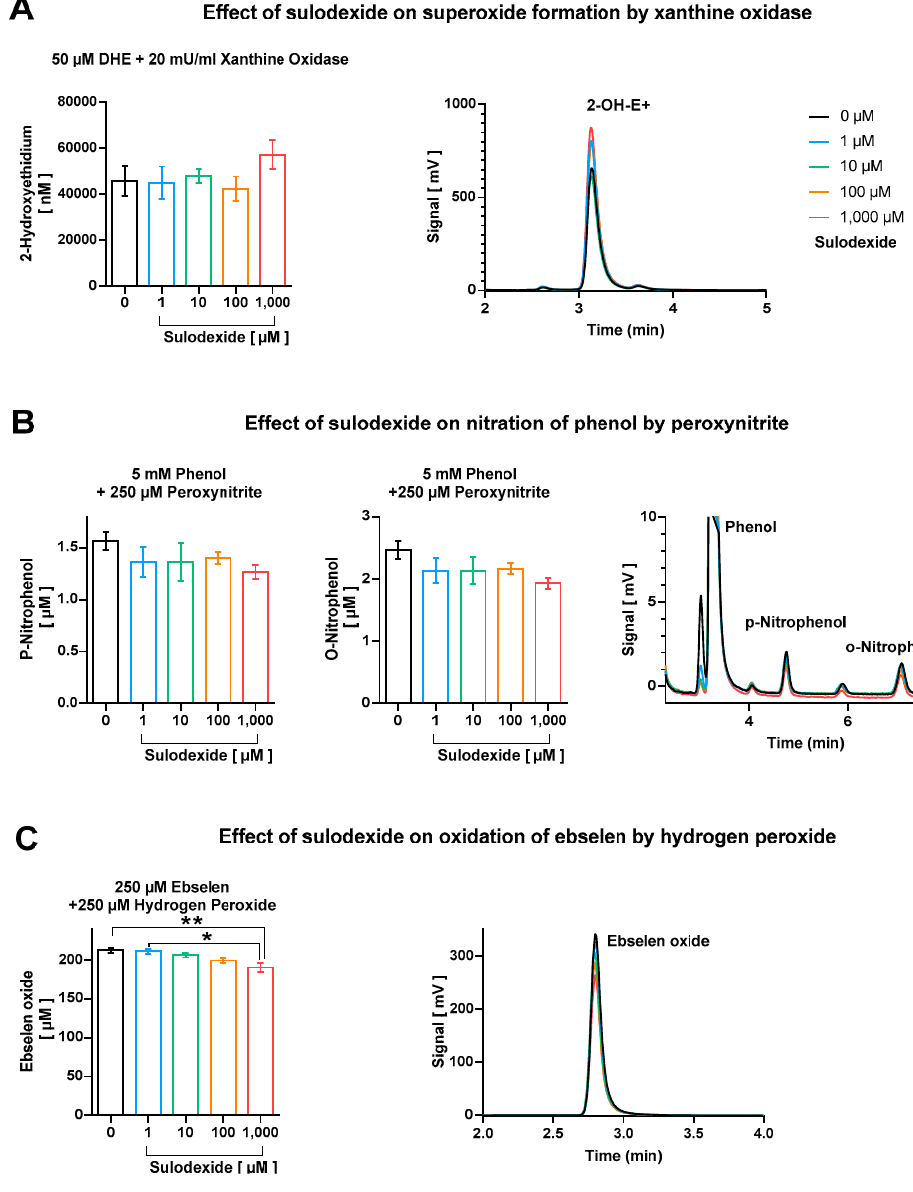
Figure 4. Direct antioxidant properties of sulodexide tested on ( A ) superoxide formation by xanthine oxidase (20 mU/mL)/1 mM hypoxanthine with hydroethidine (50 µ M), ( B ) nitration of phenol (5 mM) by peroxynitrite (250 µ M), and ( C ) oxidation of ebselen (250 µ M) by hydrogen peroxide (250 µ M). Representative chromatograms are shown besides the quantification bar graphs. Data are expressed as mean ± SE ( n = 3–5 per group; * p < 0.05; ** p <